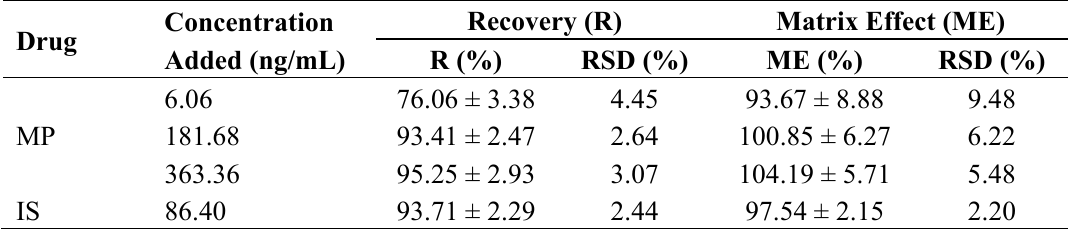
Table 2. The results of recovery and matrix effect (n =